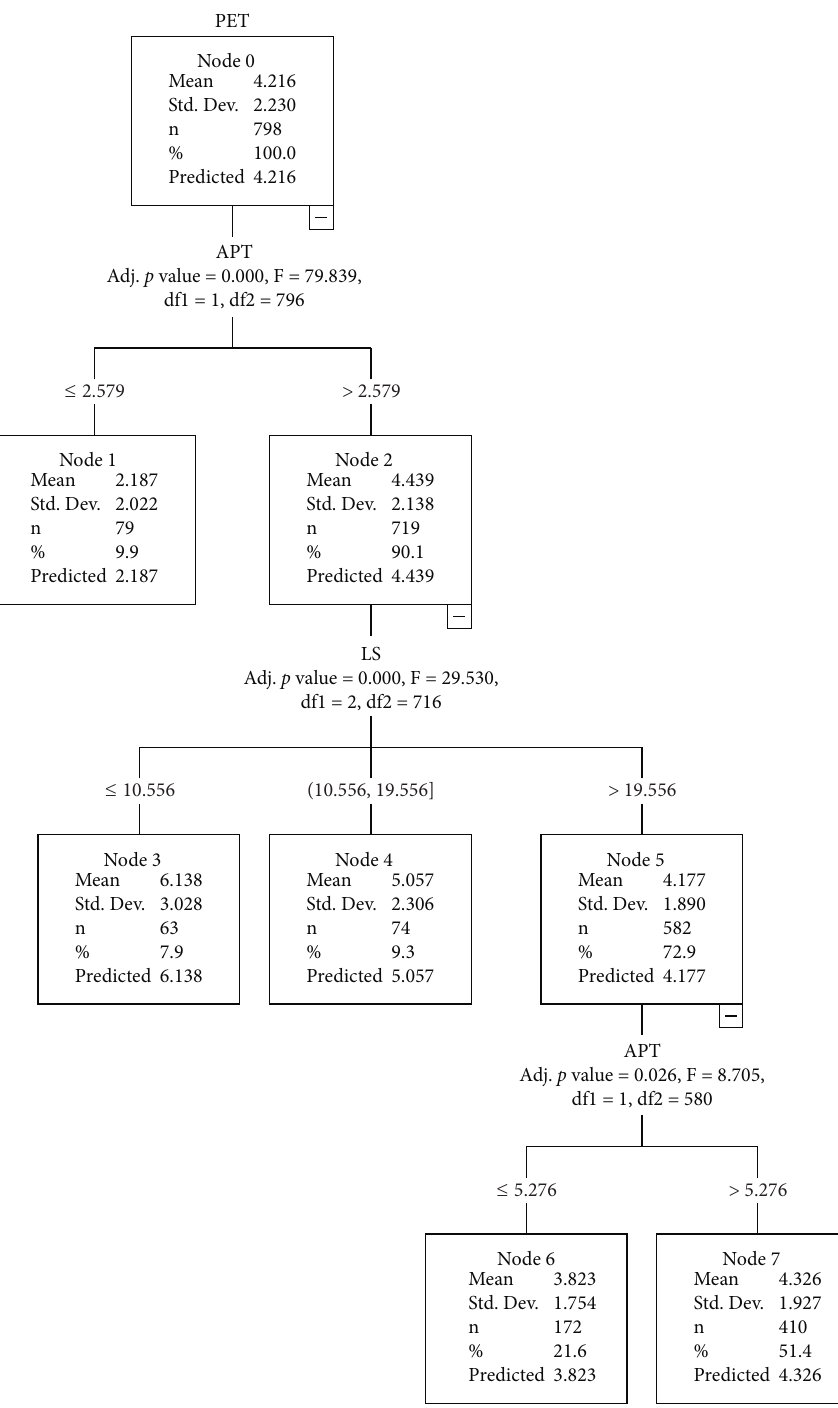
Figure 13: Classification tree result of